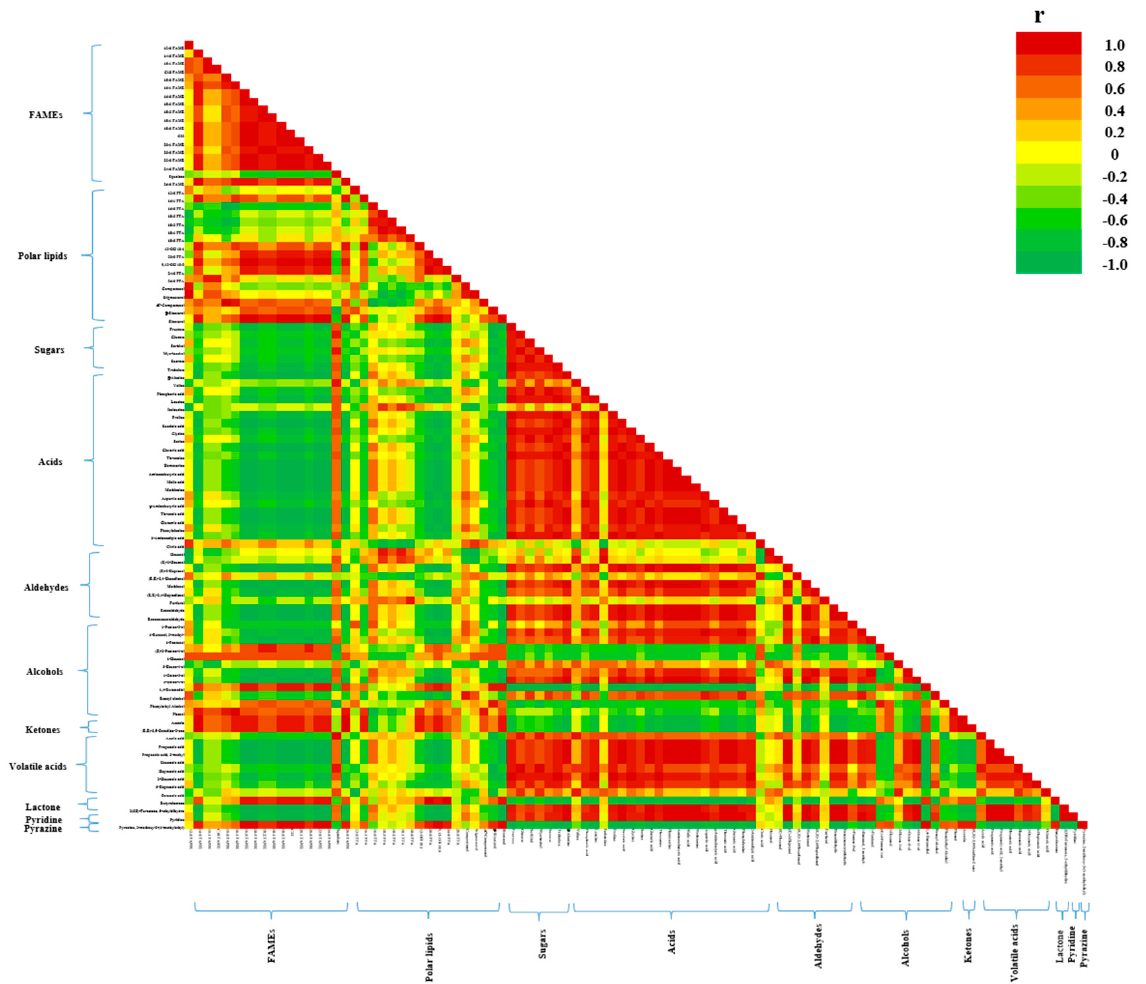
Figure 5. Lower triangular heat map represents pairwise correlation analysis between metabolites and flavor compounds during germination of sacha inchi seeds. Each square represents the Spearman’s rank correlation coefficient at a significance level of p ≤ 0.05. Orange-red, strong positive correlation (r > 0.7); green, strong negative correlation (r < − 0.7). FAME, fatty acid methyl ester; FFA, free fatty acid.